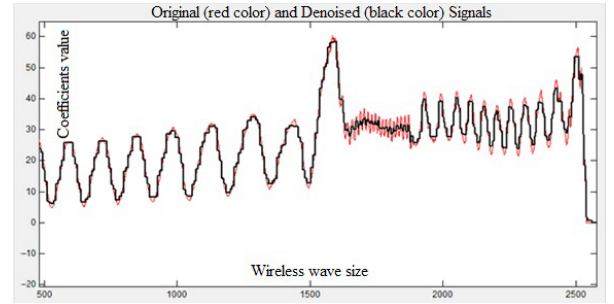
Figure 5. Result of the signal